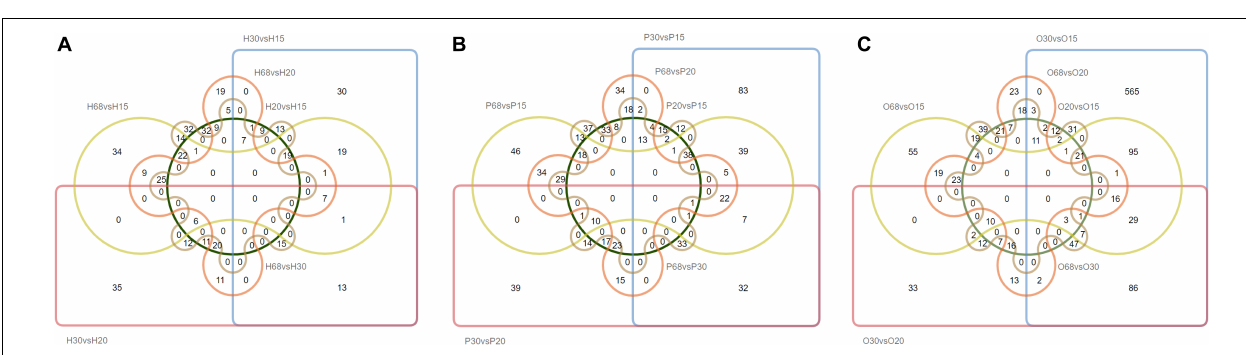
FIGURE 2 | Venn diagrams of the DEGs in the three tissues of HPO axis at four ages. The capital letters in the upper left correspond to the analysis of different tissues [ (A) hypothalamus, (B) pituitary, and (C) ovary]. This naming convention is the same as the following